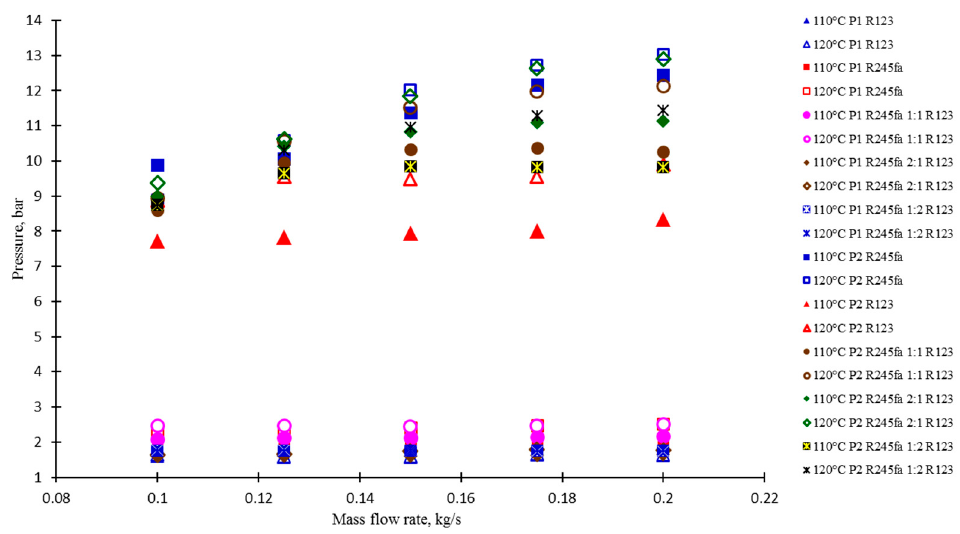
Figure 8. Pressure at pump inlet and outlet with mass flow rate for R245fa, R123, and mixed working fluids.